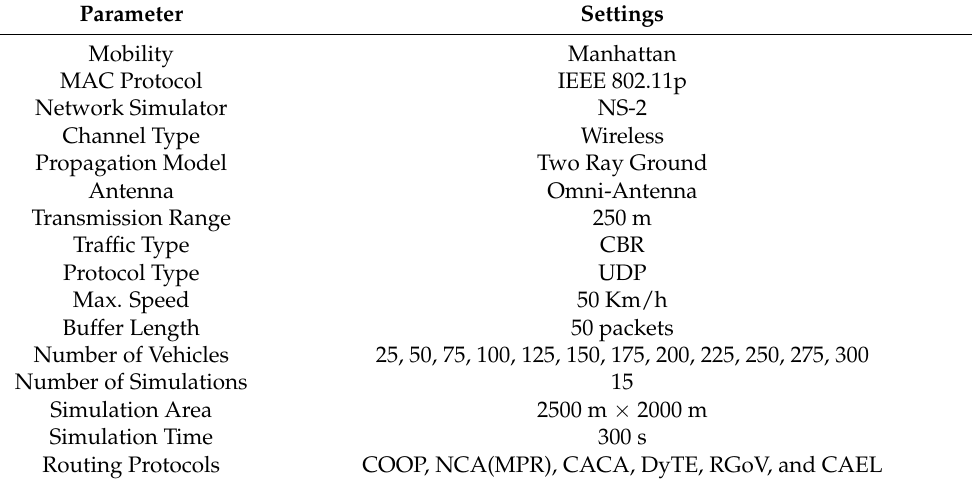
Table 1. Simulation